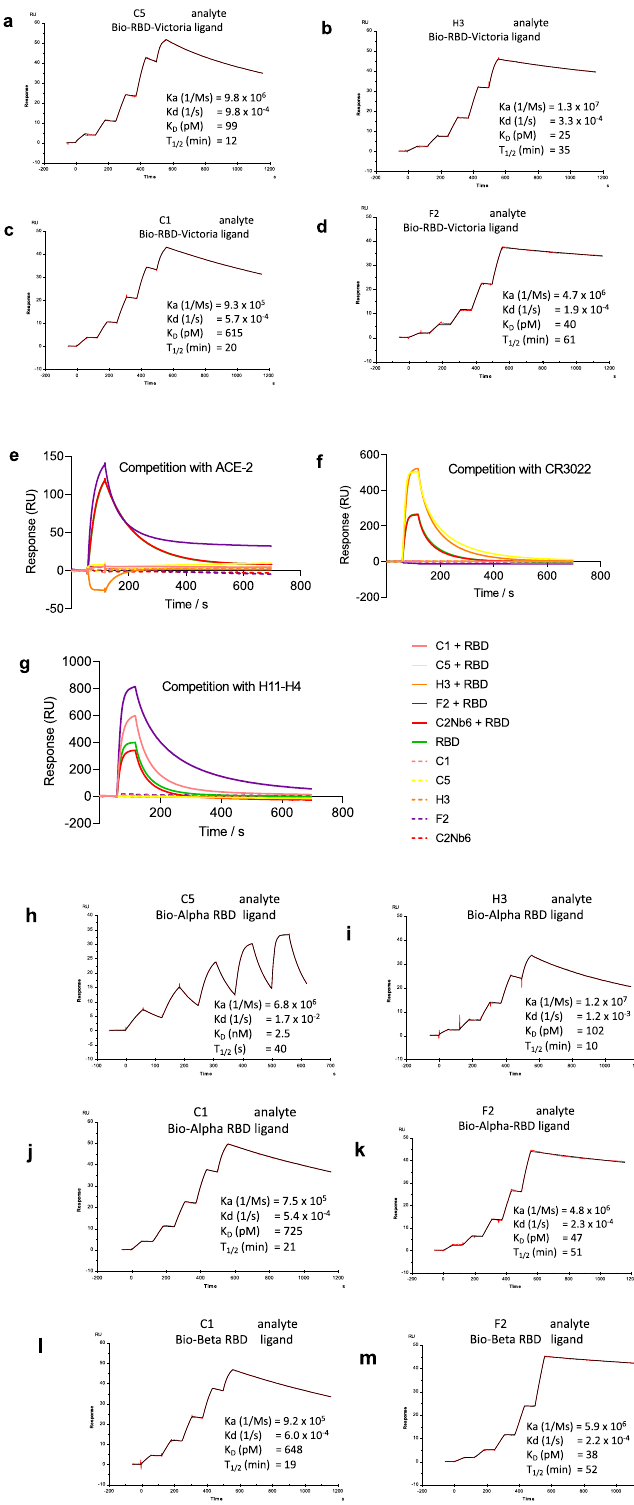
Fig. 1 Nanobody binding kinetics. a – d SPR sensorgrams showing binding kinetics of nanobody C5, H3, C1 and F2 for RBD Victoria (immobilised as biotinylated RBD on the chip), e – g SPR sensorgrams of competition assays between RBD and C5, H3, C1, F2 for binding to e ACE-2, f CR3022 and g H11- H4, with all ligands immobilised as Fc fusion proteins and C2Nb6 (an anti-Caspr2 nanobody) used as a negative control, h – k binding kinetics of nanobody C5, H3, C1 and F2 to Alpha RBD ( l , m ) C1 and F2 binding to Beta RBD (immobilised as biotinylated RBD on the